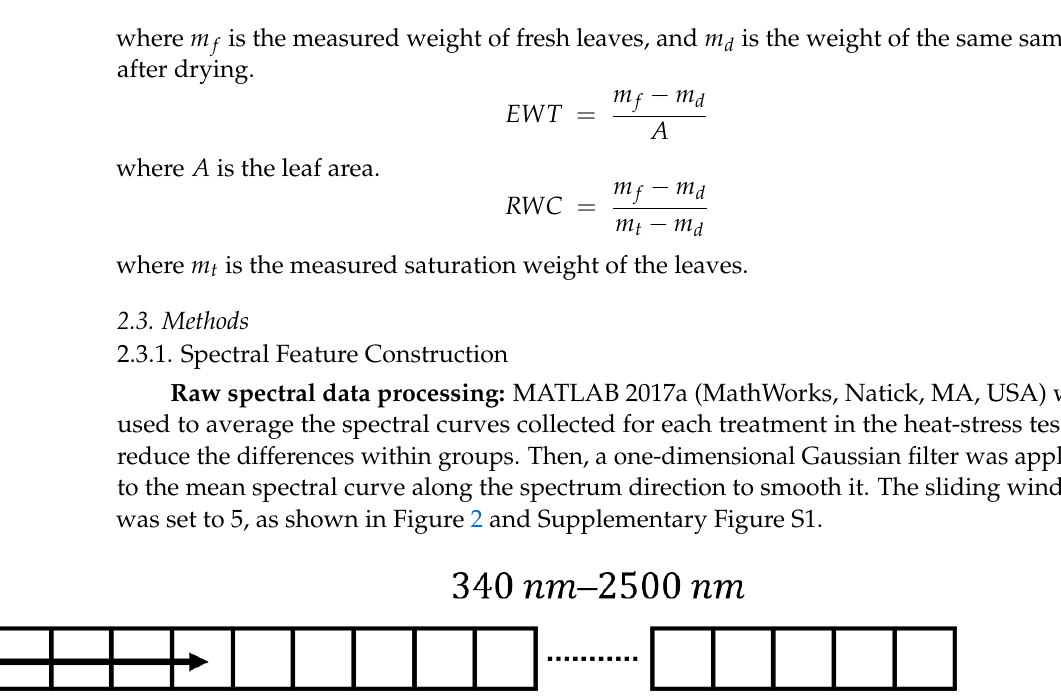
Figure 2. Schematic diagram of one-dimensional Gaussian filtering along the spectrum direction, with a sliding window of 5.